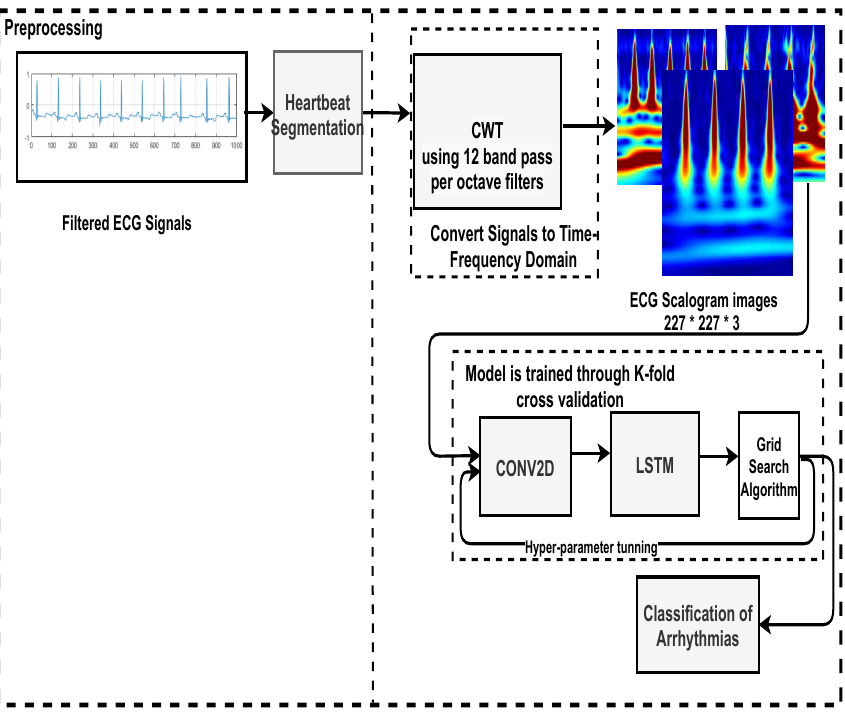
Figure 6. Block-diagram of the proposed